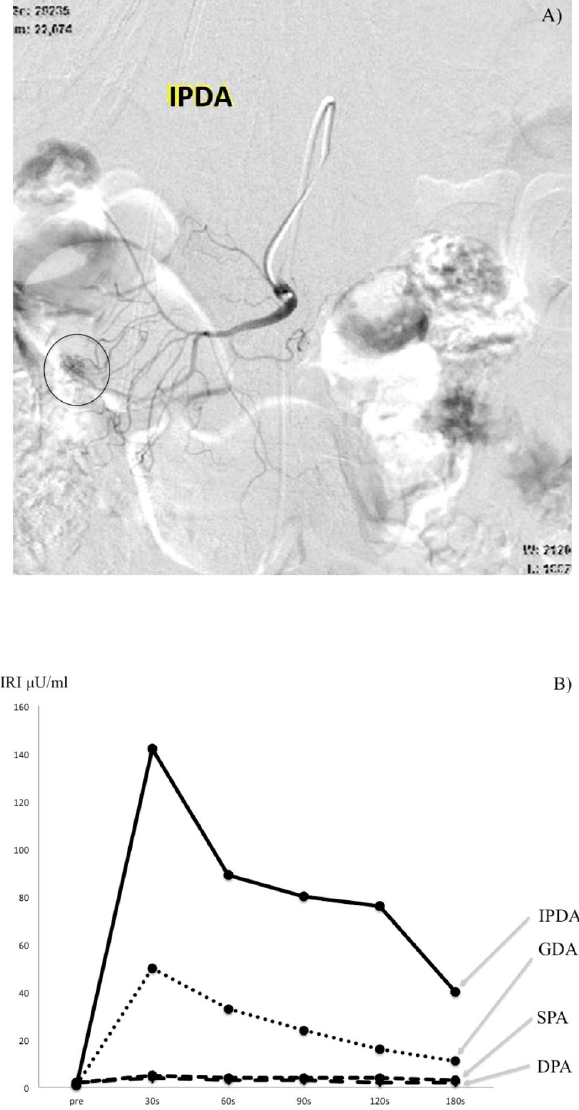
Figure 1. Results of the selective arterial calcium injection test in a patient with insulinoma. In this patient, immunoreactive insulin (IRI) levels increased at 30 s after the injection into the inferior pancreaticoduodenal artery (IPDA) ( A , B ). GDA gastroduodenal artery; SPA splenic artery, DPA distal pancreatic